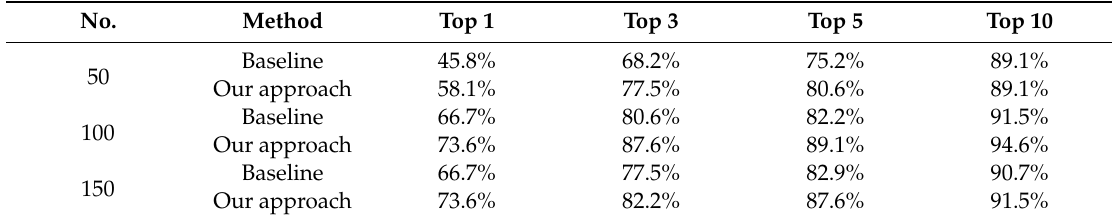
Table 2. Top n inclusion rates in the mining results of term translations obtained by changing the number of snippets.